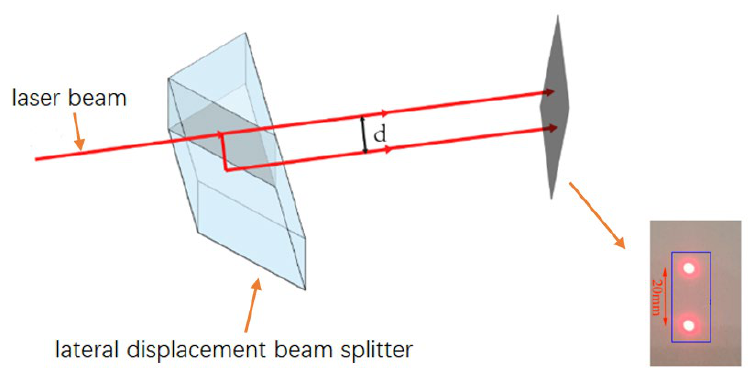
Figure 1. Theoretical diagram of the laser virtual scale.